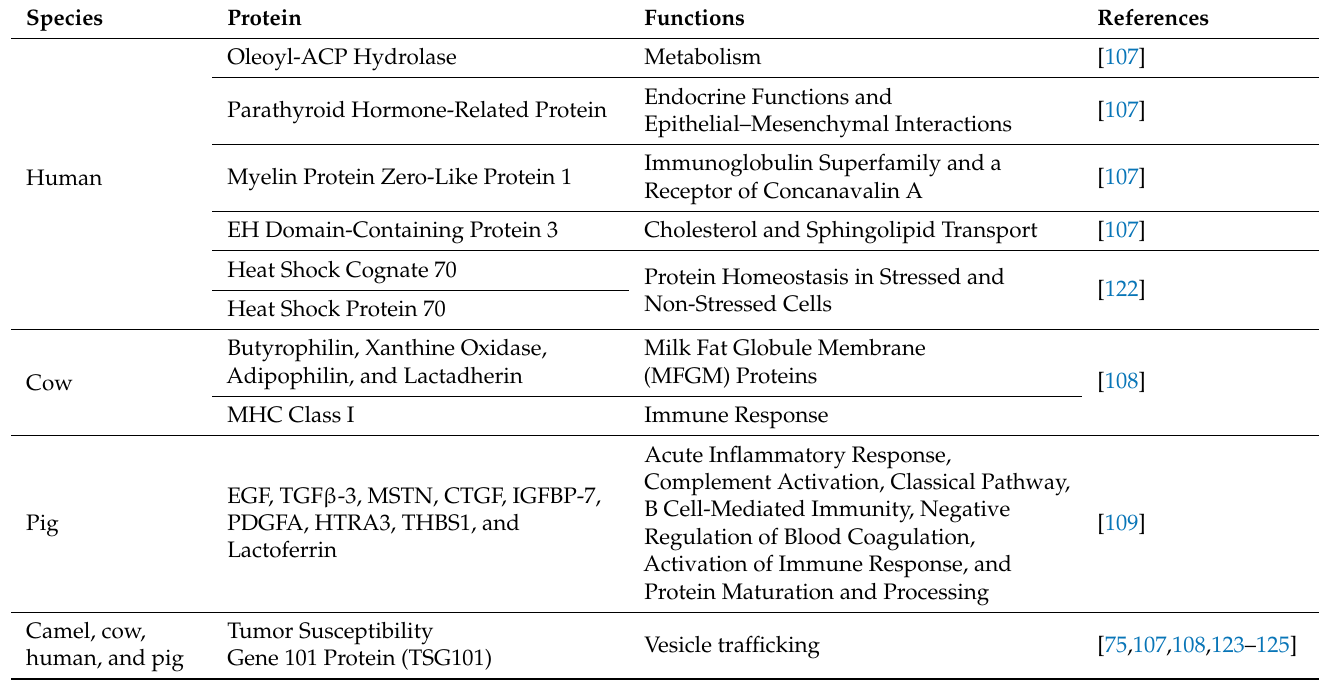
Table 3. Top proteins identified in milk EVs that were identified by the Western blot